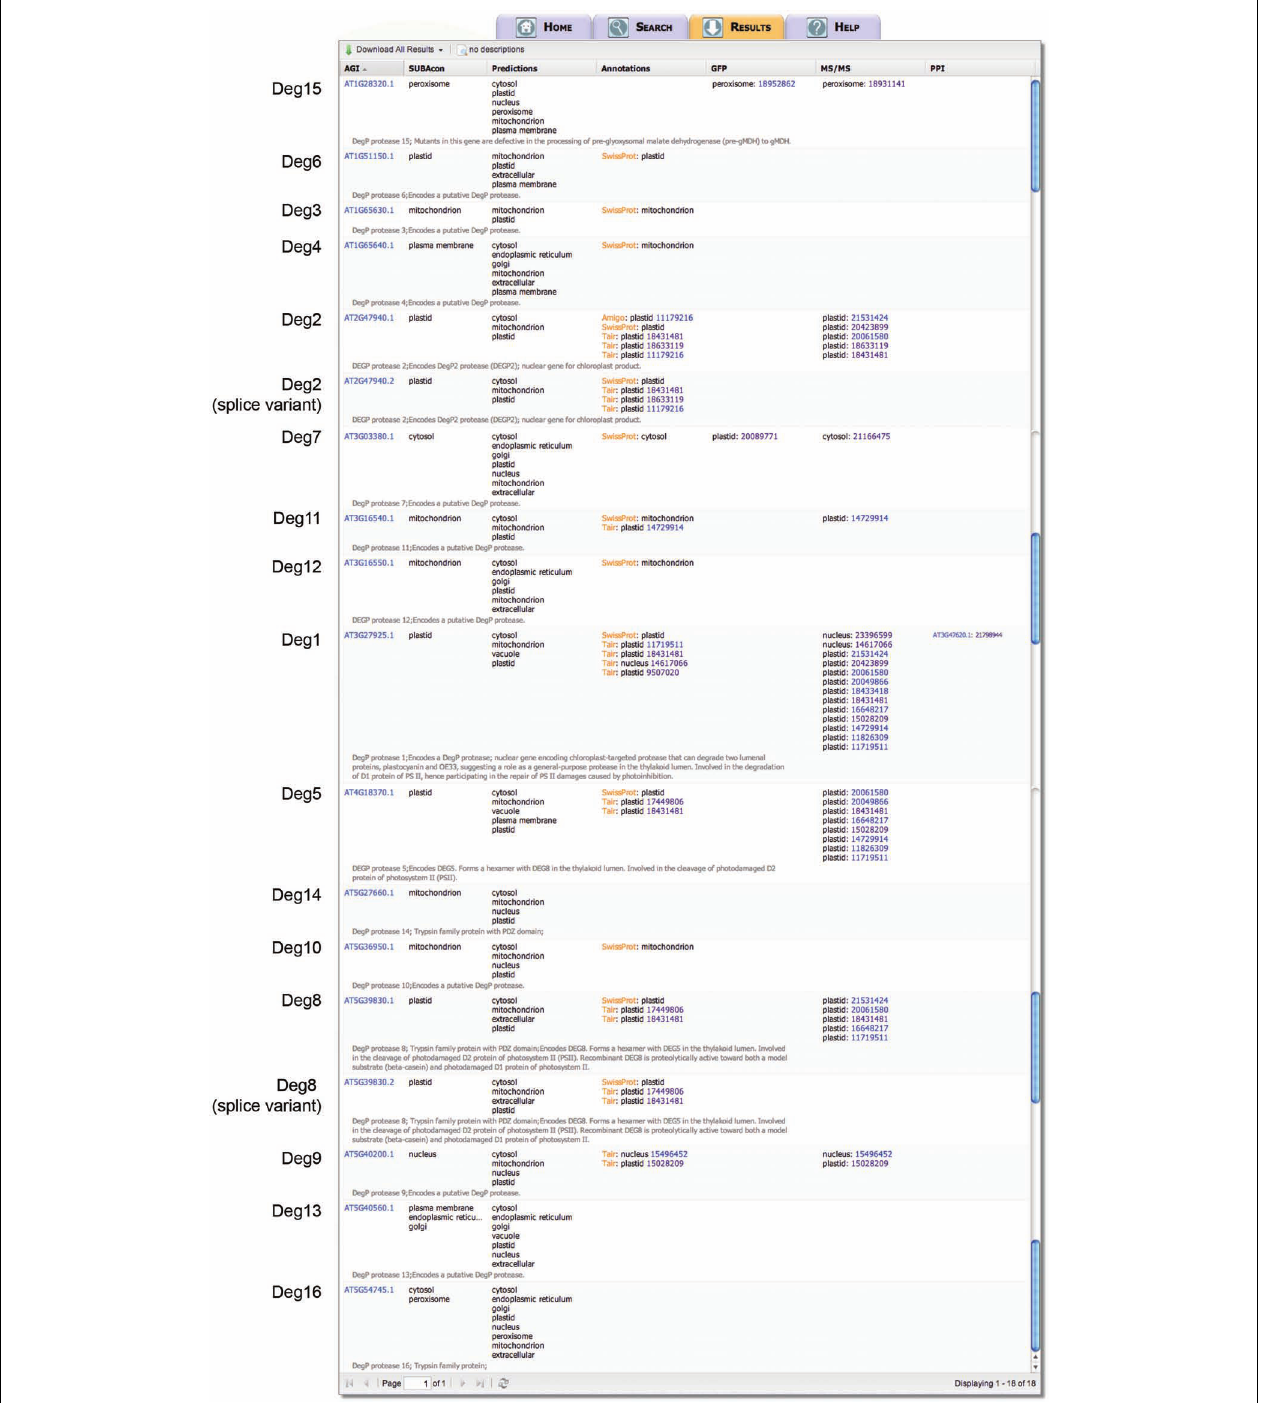
FIGURE 2 | SUBA3 result output for Deg proteases in Arabidopsis . Querying the SUBA3 database by entering “DegP protease” as descriptor in the “keyword” input box returns results for 18 gene products with location evidence. Displayed are the location calls by SUBAcon, the predicted locations determined by the 22 predictors in SUBA3 (column “Predictions”),